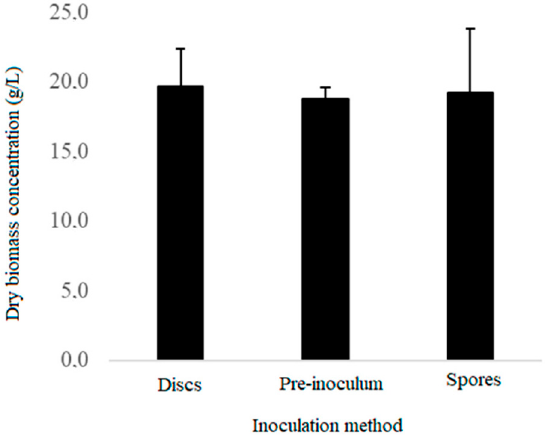
Figure 2. The effect of the inoculum method on the dry biomass weight of Ganoderma sp. mycelia.